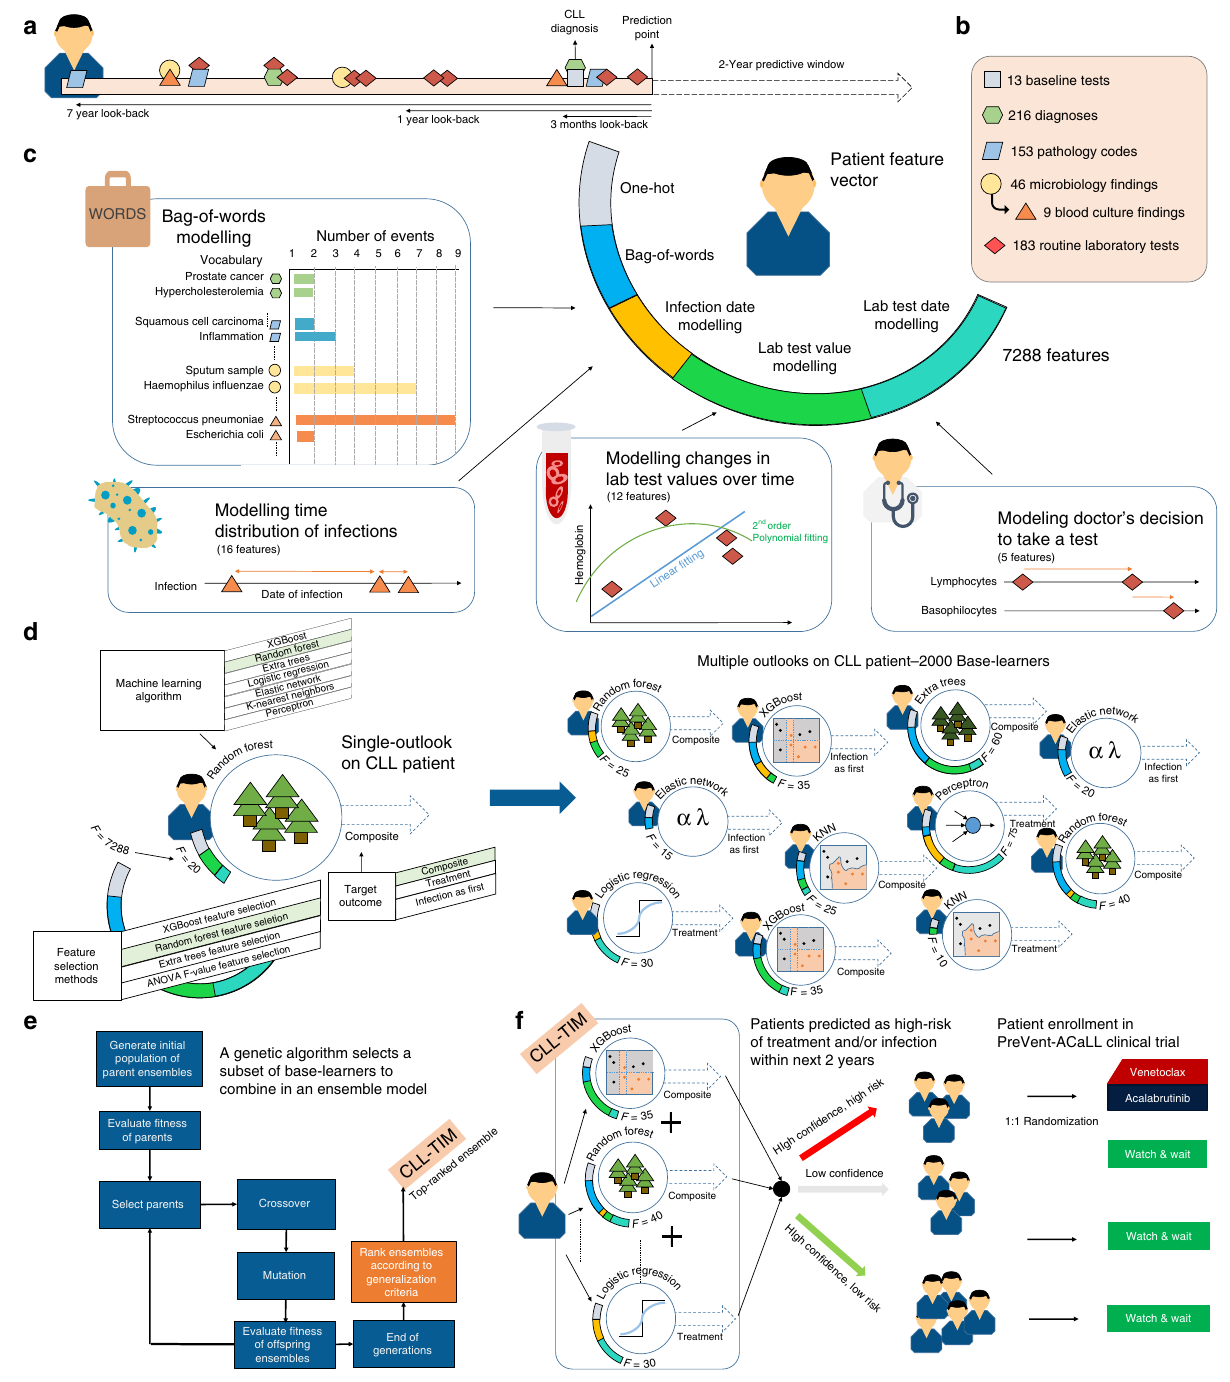
Fig. 1 Development of CLL-TIM and selection of high-risk patients for PreVent-ACaLL clinical trial. a For each patient, we modeled patient data in three look-back windows. Prediction-point was set at 3-months post-diagnosis and the 2-year risk of infection or CLL treatment (composite outcome) was the target outcome. b We assembled fi ve datasets on 4149 CLL patients from the Nationwide Danish CLL registry, the Danish Microbiology Database, the Persimune data warehouse and health registries. c Using the Bag-Of-Words (BOW) approach, we modeled the frequency of occurrence of 216 diagnoses, 153 pathologies, and 46 microbiology fi ndings (including 9 blood culture fi ndings). We modeled the distribution of past infections and laboratory test results and designed latent features that model urgency of patient ’ s condition and patient symptoms as interpreted by the treating physician. d Generation of a single base-learner (single outlook) required the random selection of: a machine learning algorithm; hyper-parameters; a target outcome and feature selection. In total, using this randomized protocol, we generated 2000 base-learners, each with their unique outlook into a patient ’ s history. e A genetic algorithm (GA) was designed to generate 29 ensembles of 2 – 30 base-learners each. The generated ensembles were then post-ranked according to multiple criteria designed to maximize the generalizability of the ensemble. f The top-ranked ensemble chosen as CLL-TIM was then invoked to predict the 2-year composite outcome on a previously unseen test cohort and subsequently for the selection of high-risk patients for the PreVent A-CaLL Clinical